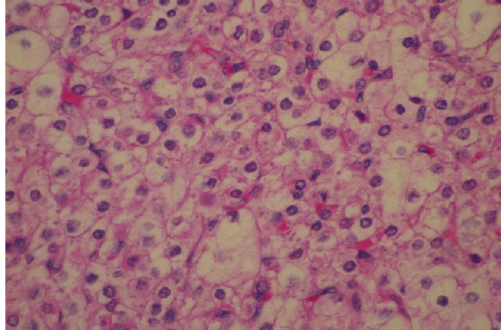
Figure 2: Histologic section obtained from the gross tumor. Note the eosinophilic and vacuolated appearance of the cellular structure characteristic of steroid cell, not otherwise specified.